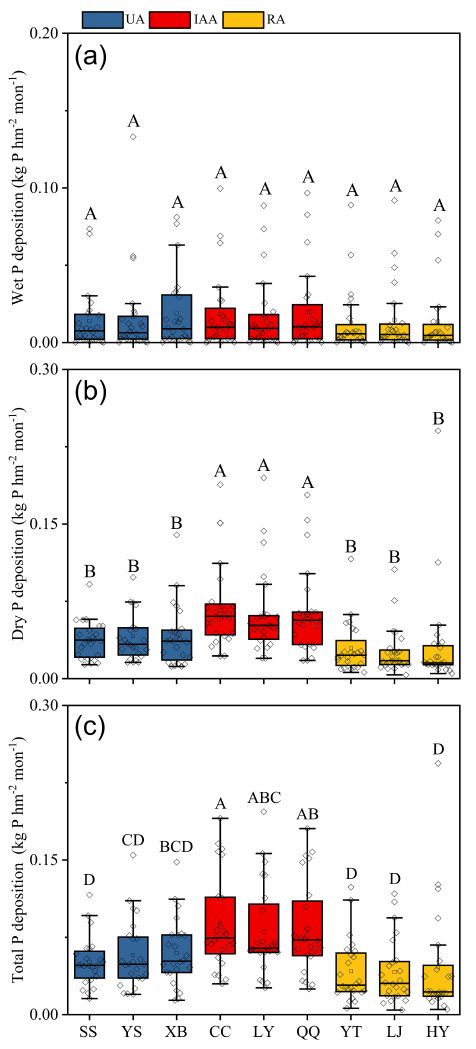
Figure 5. Average monthly phosphorus wet (a) , dry (b) and total (c) deposition fluxes at nine sites. Each box contains 24 months of P deposition fluxes. Different capital letters suggest that the dif- ference in the fluxes among the nine sites is significant ( p< 0 . 05) ( n = 24 for each box). In addition, different colored columns repre- sent different areas.